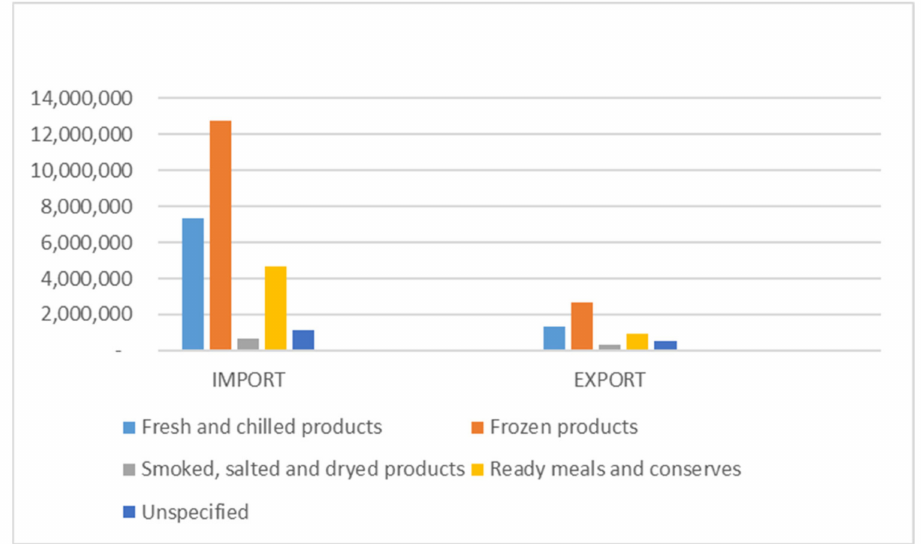
Figure 1. Imports and Exports of fishery and aquaculture products by main preservation categories— Extra EU-trade (value in thousands EUR). Source: our elaboration on European Commission data